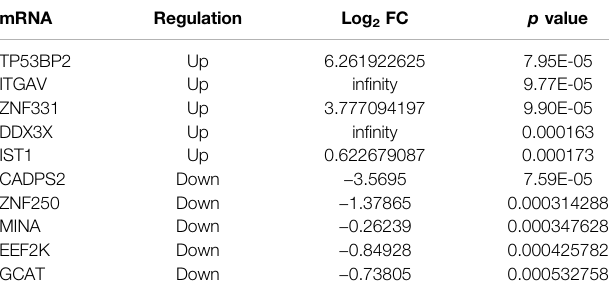
TABLE 4 | Top 10 differentially expressed mRNAs in decidua of URSA patients. mRNA